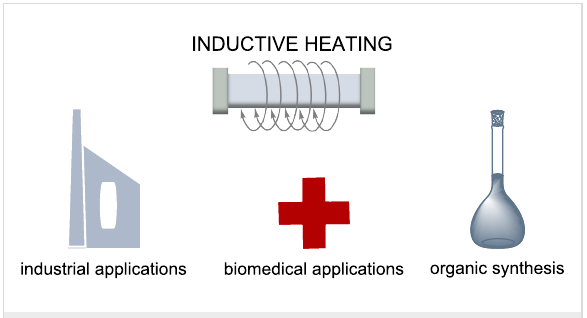
Figure 1: Inductive heating, a powerful tool in industry and the Life Sciences.